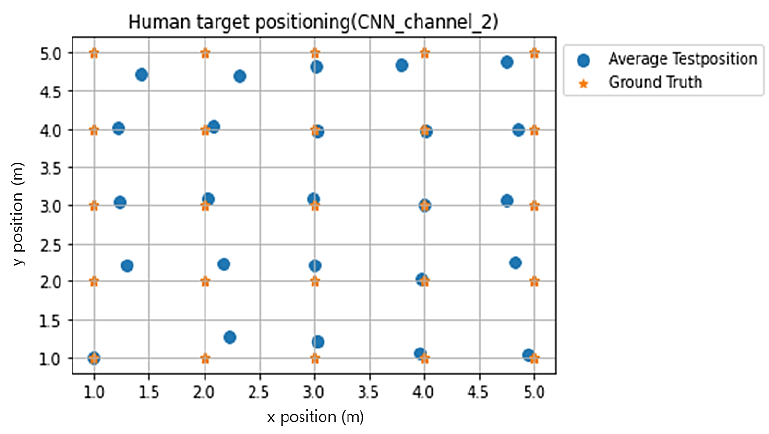
Table 2. Comparison of validation accuracy and average localization